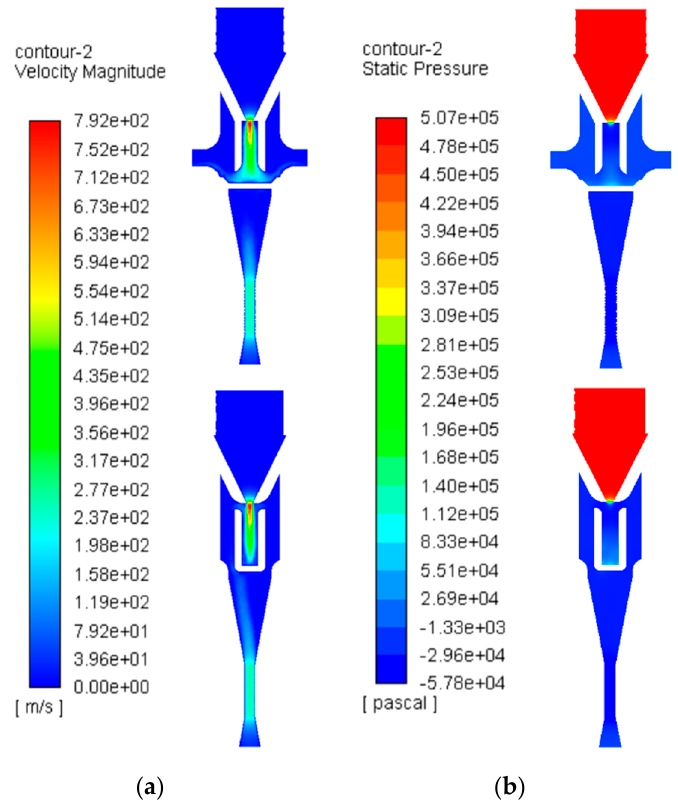
Figure 20. Numerical simulation of VGSN. ( a ) Velocity cloud map. ( b ) Pressure cloud